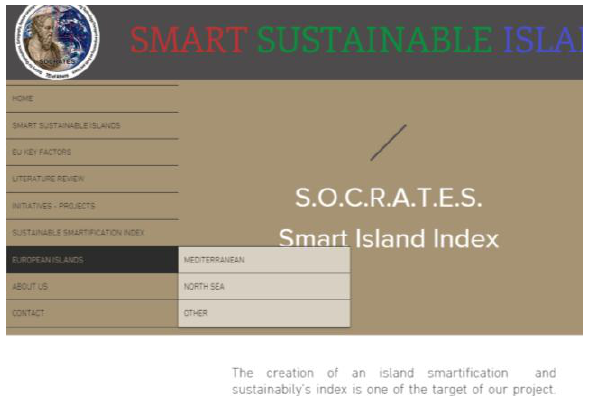
Figure 3: The SOCRATES site for smart sustainable European islands & the smartification and sustainability Island’s index (SOCRATES S 2 I 2 ).